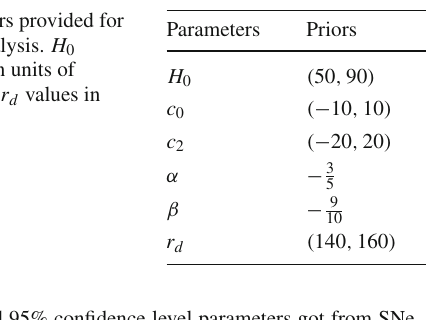
Table 2 68% and 95% confidence level parameters got from SNe, in which we fixed α and β . H 0 values are given in units of Km/s/Mpc,